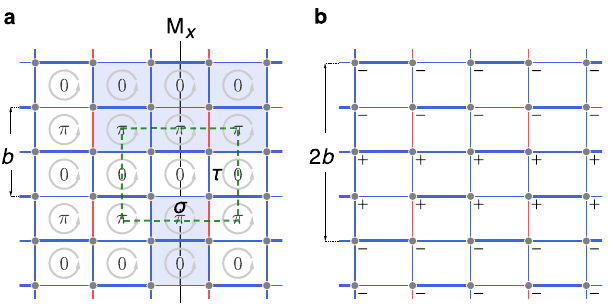
Fig. 2 A lattice model with nonsymmorphic symmetry in the momentum space. a The fl ux con fi guration and gauge connections of a lattice model. The chosen unit cell is speci fi ed by the green dashed rectangle. The blue shaded regions respect M x and have a unit lattice length along the y direction. Both of them have a net fl ux π mod 2 π . b The gauge transformation to restore the original gauge connections after re fl ection M